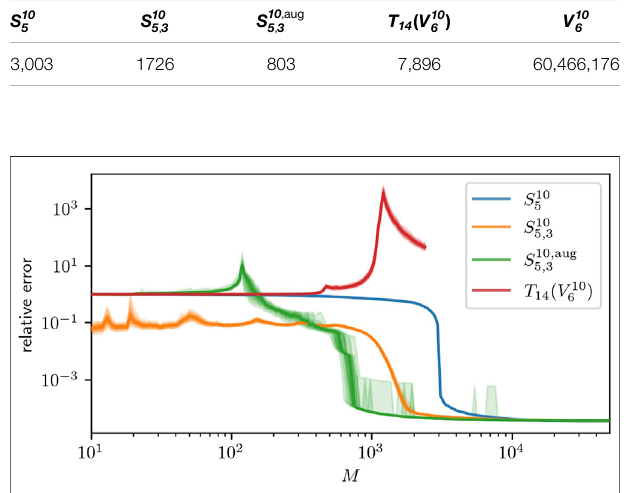
FIGURE 3 | 0.15 – 0.85 quantiles for the recovery error in S 10 5 (blue), S 10 5 , 3 (orange), S 10 , aug 5 , 3 (green), and T 14 ( V 10 6 ) (red). The relative error is computed with respect to the L 2 -norm using a Monte Carlo estimation with 10 6 samples. The experiment for T 14 ( V 10 6 ) was stopped early at M (cid:1) 1,200 due to its prohibitive computational demand and because the expected behaviour is already observable.